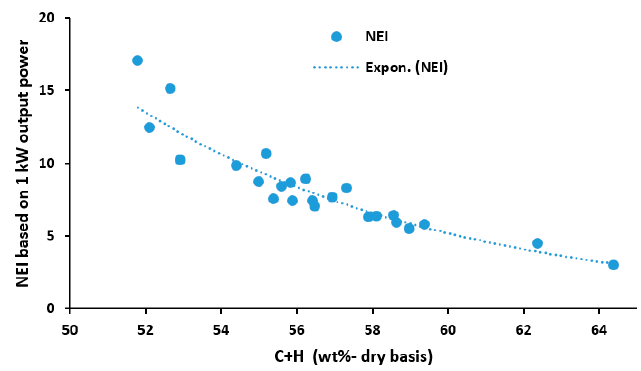
Figure 7. Variation of NEI versus element percentage of C and H .